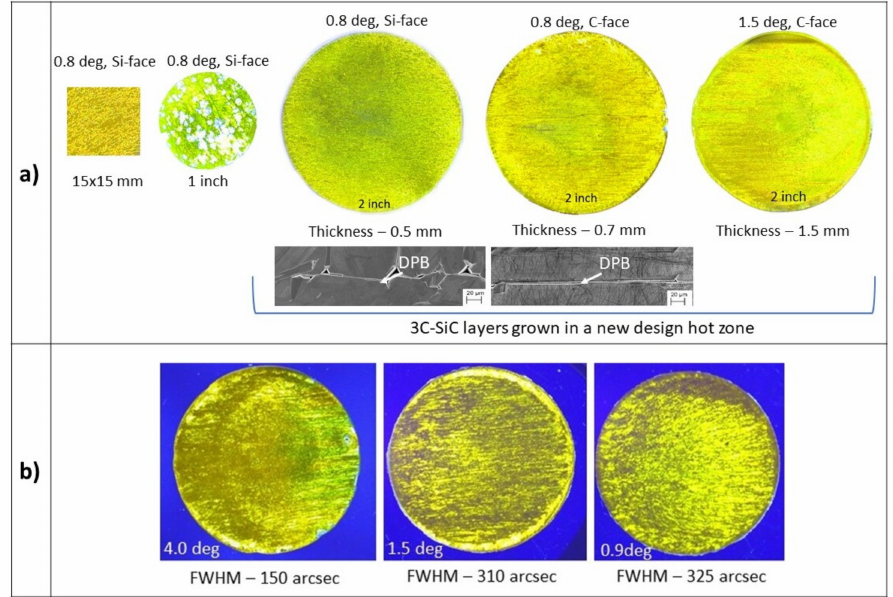
Figure 18. ( a ) 3C-SiC growth on hexagonal SiC substrates using enhanced sublimation epitaxy. ( b ) Polarized light optical micrographs of 2.5 mm-thick 3C-SiC layers grown on 2-inch 4.0, 1.5, and 0.9 degrees off-oriented SiC (000-1) substrates. All samples were grown at 1950 ◦ C in vacuum (5 × 10 -4